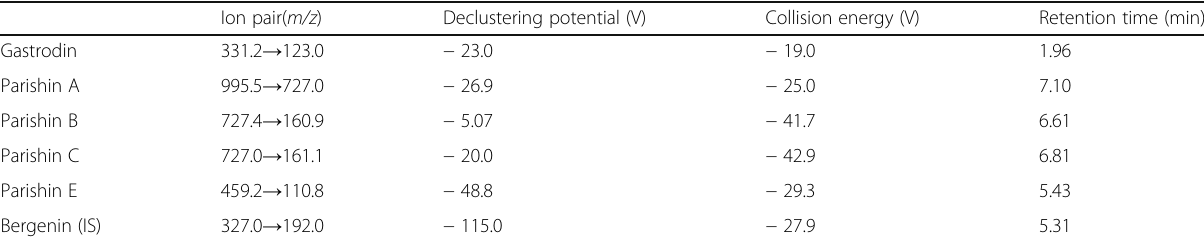
Table 1 Ion pair and MS parameter for the analysis of the five analytes and the internal standard in negative ion ESI mode Ion pair( m/z ) Declustering potential (V) Collision energy